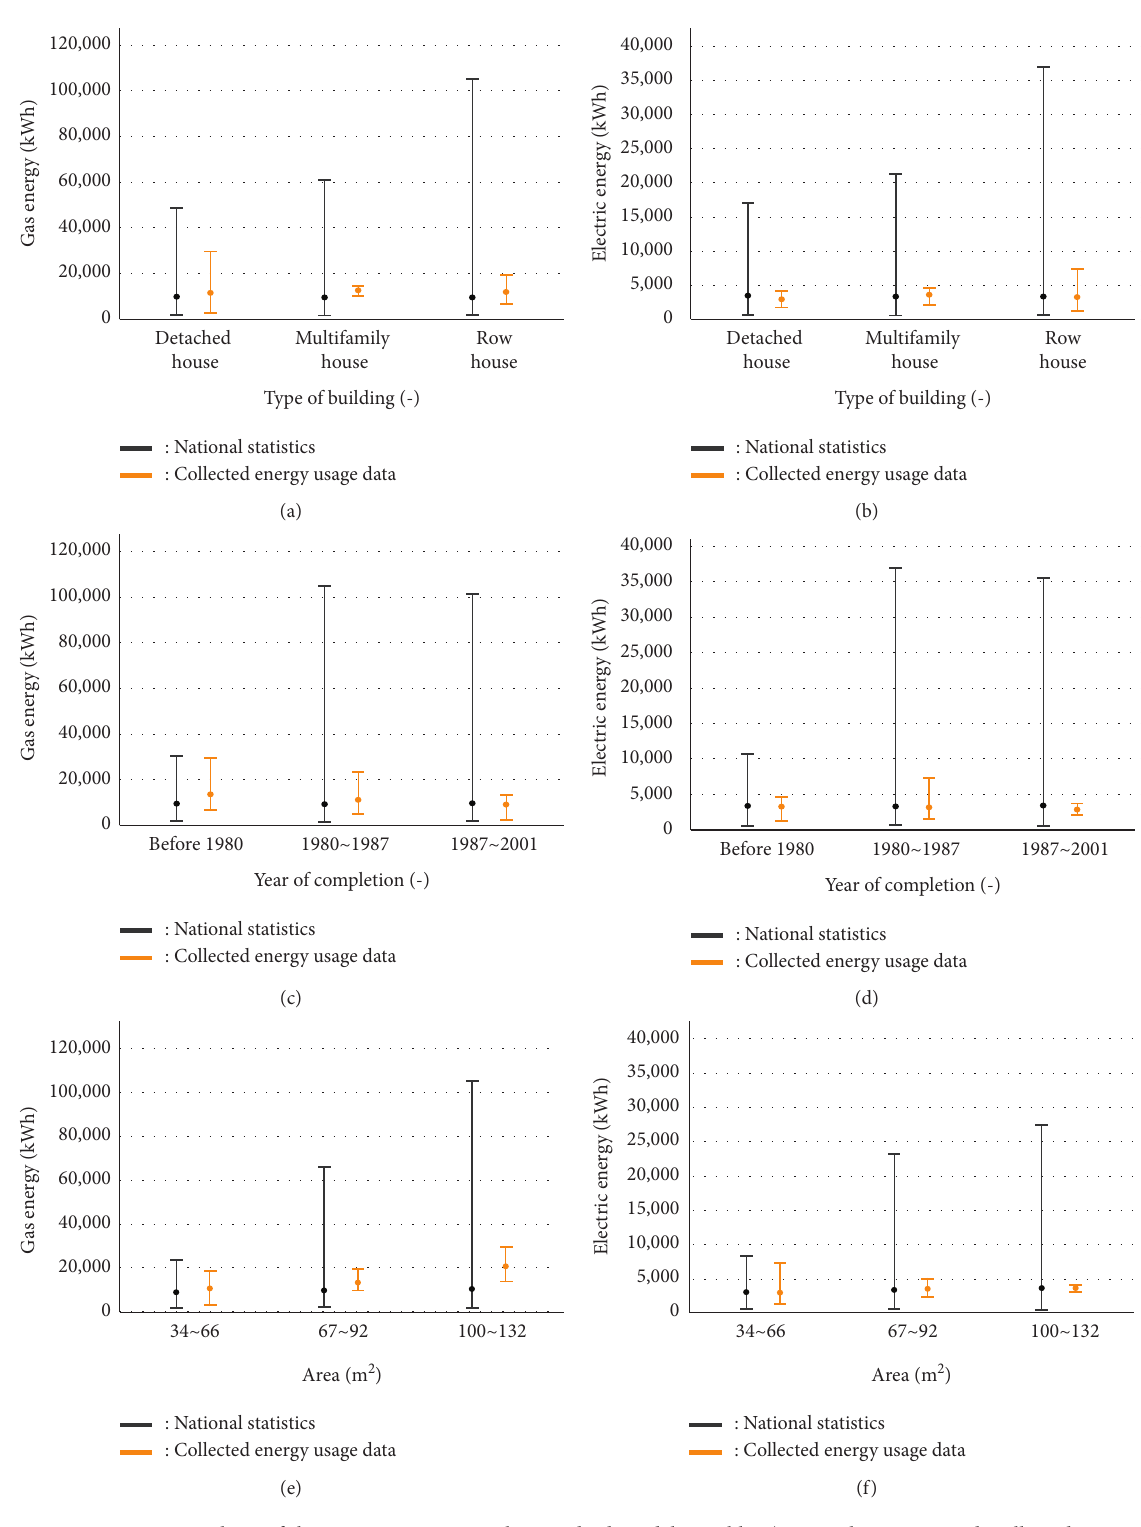
Figure 11: Comparative analysis of the energy usage range by standard model variables (National Statistics and Collected Energy Usage Data). (a) Gas energy: type of building. (b) Electric energy: type of building. (c) Gas energy: year of completion. (d) Electric energy: year of completion. (e) Gas energy: area. (f) Electric energy: